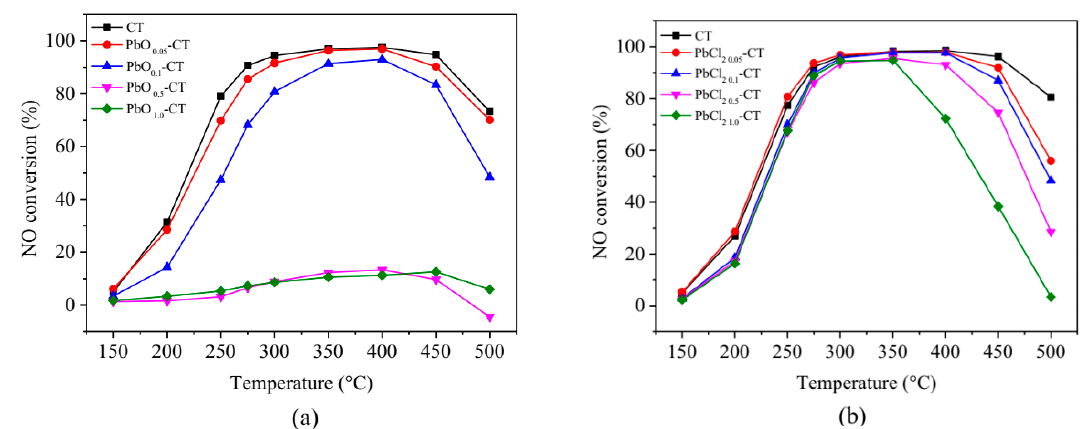
Figure 15. NO conversion of PbO x -CT ( a ) and PbCl 2 x -CT ( b ). Reaction condition: [NO] = [NH 3 ] = 1000 ppm, [O 2 ] = 3%, N 2 balance, total flow rate = 500 mL/min, GHSV = 90,000 h − 1 [69].